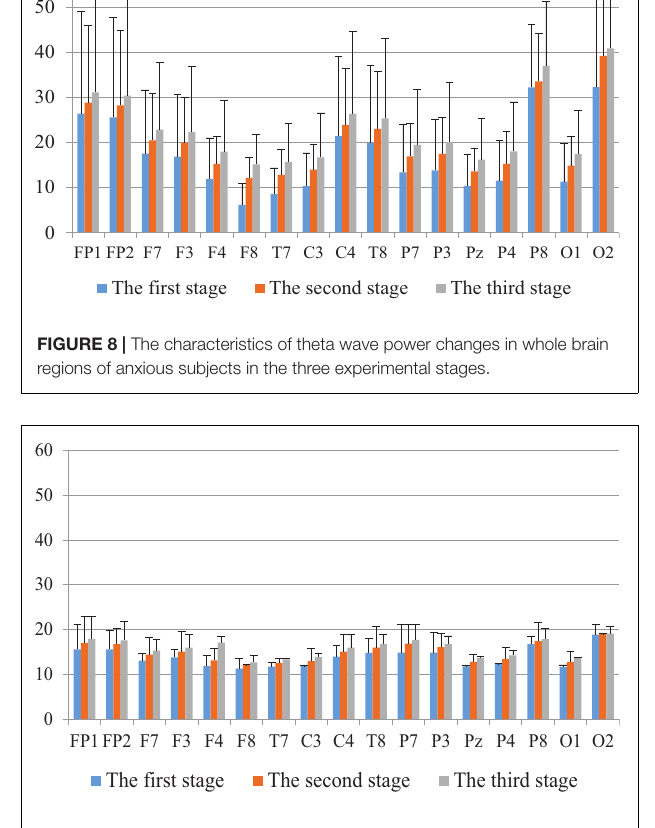
number of processing groups ( k = 2), number of samples ( n = 390), degree of freedom between groups is k − 1, and degree of freedom within group is n ( k − 1). In Table 1 , F (1,339) = 14.62, indicating that the degree of freedom between groups is 1, and the degree of freedom within group is 339. Similarly, P <